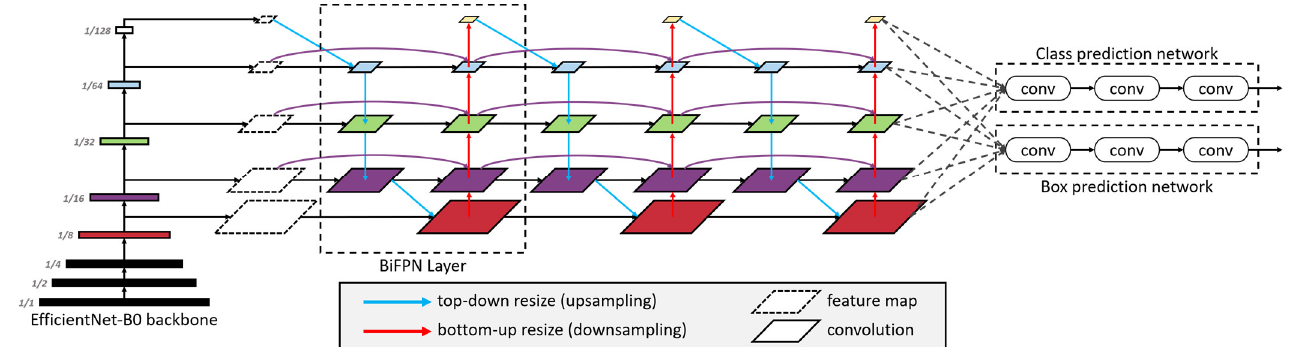
Figure 7. Architecture of